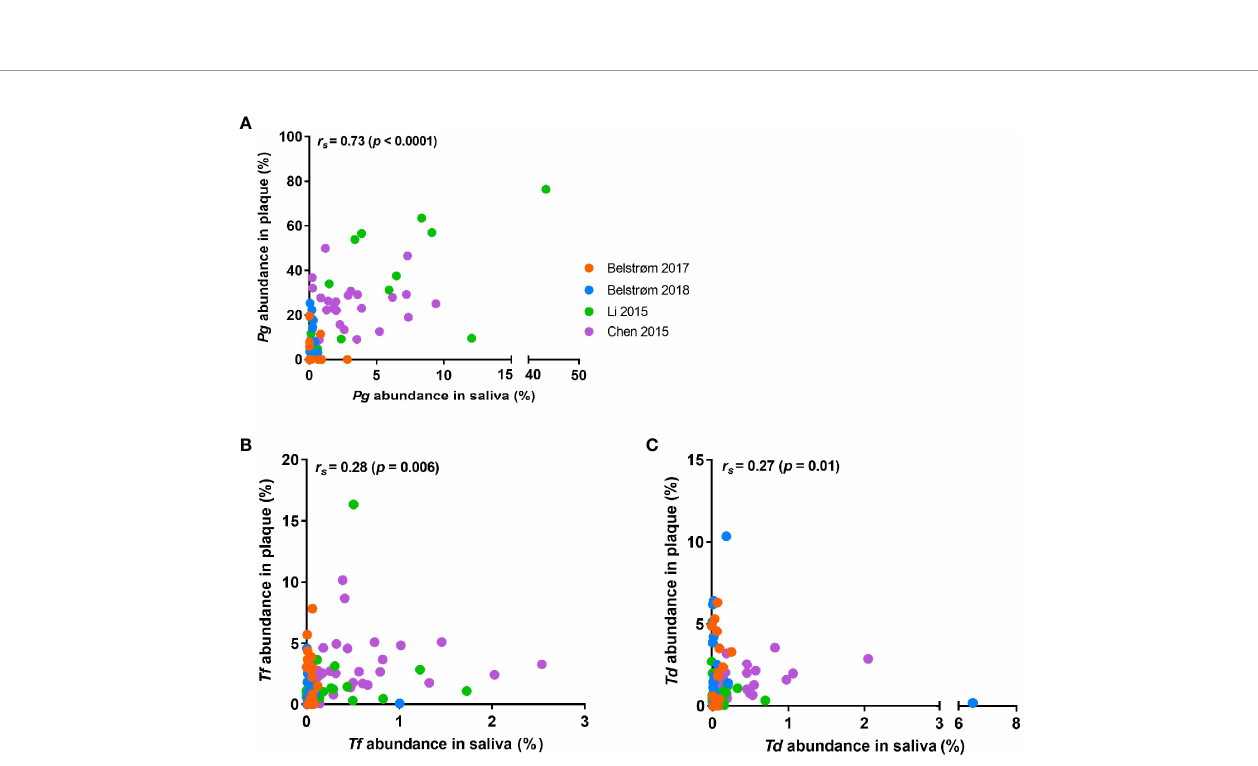
FIGURE 6 | Scatter plots showing the distributions of the relative abundance of: (A) P. gingivalis ; (B) T. forsythia ; (C) T. denticola in saliva and subgingival plaque samples per patient, as determined in studies using 16S rRNA gene sequencing techniques. Each dot represents one patient, and patients from different studies are indicated by different colors of the dots. Spearman ’ s rank correlation coef fi cient ( r s ) and p value are shown in each